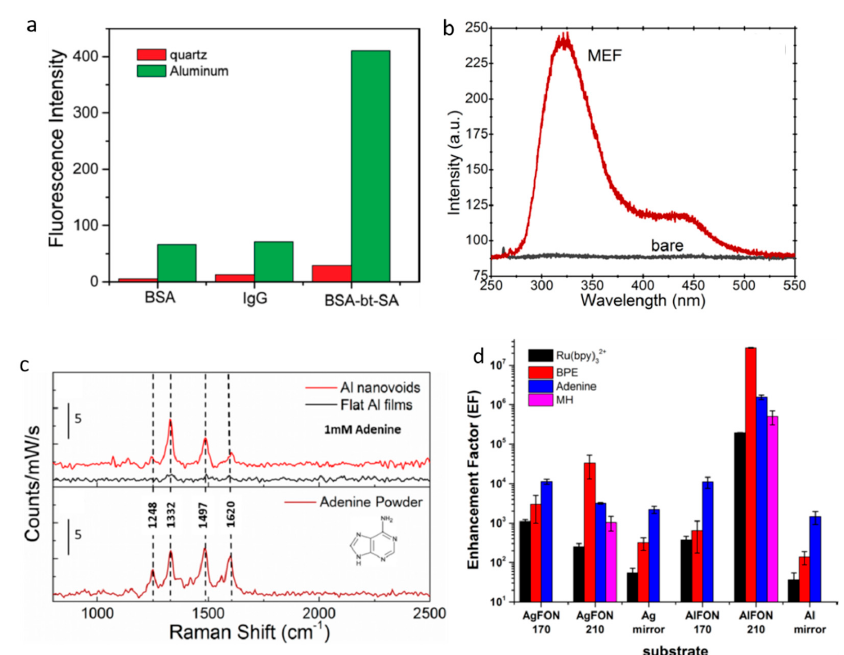
Figure 3. Biosensing using Al NSs. ( a ) Fluorescence intensities of biomolecules show the enhancement on Al nanostructured substrates compared to quartz. (Adapted from Ray et al. [129]). ( b ) Fluorescence spectra of adenine on Al NP array show large enhancement compared to bare quartz. (Adapted from Jha et al. [130]). ( c ) Surface-enhanced Raman scattering (SERS) of adenine on Al nanovoids. (Adapted from Ding et al. [118]). ( d ) Enhancement factors of biomolecules on various substrates show largest resonance Raman enhancement on ALFON. (Adapted from Sharma et al. [119]).